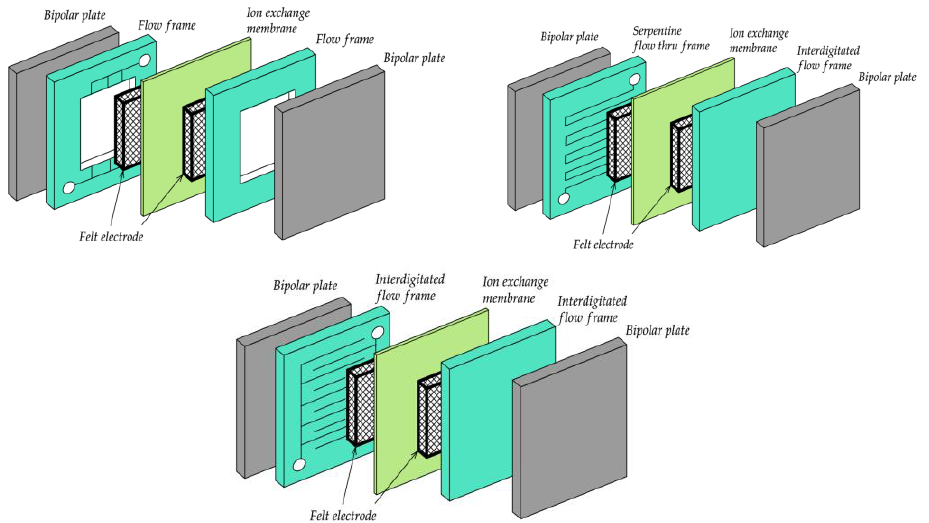
Figure 2. Individual components within a cell with various flow fields in the bipolar plate flow- through ( top left ), interdigitated ( top right ), serpentine flow-by ( bottom ).